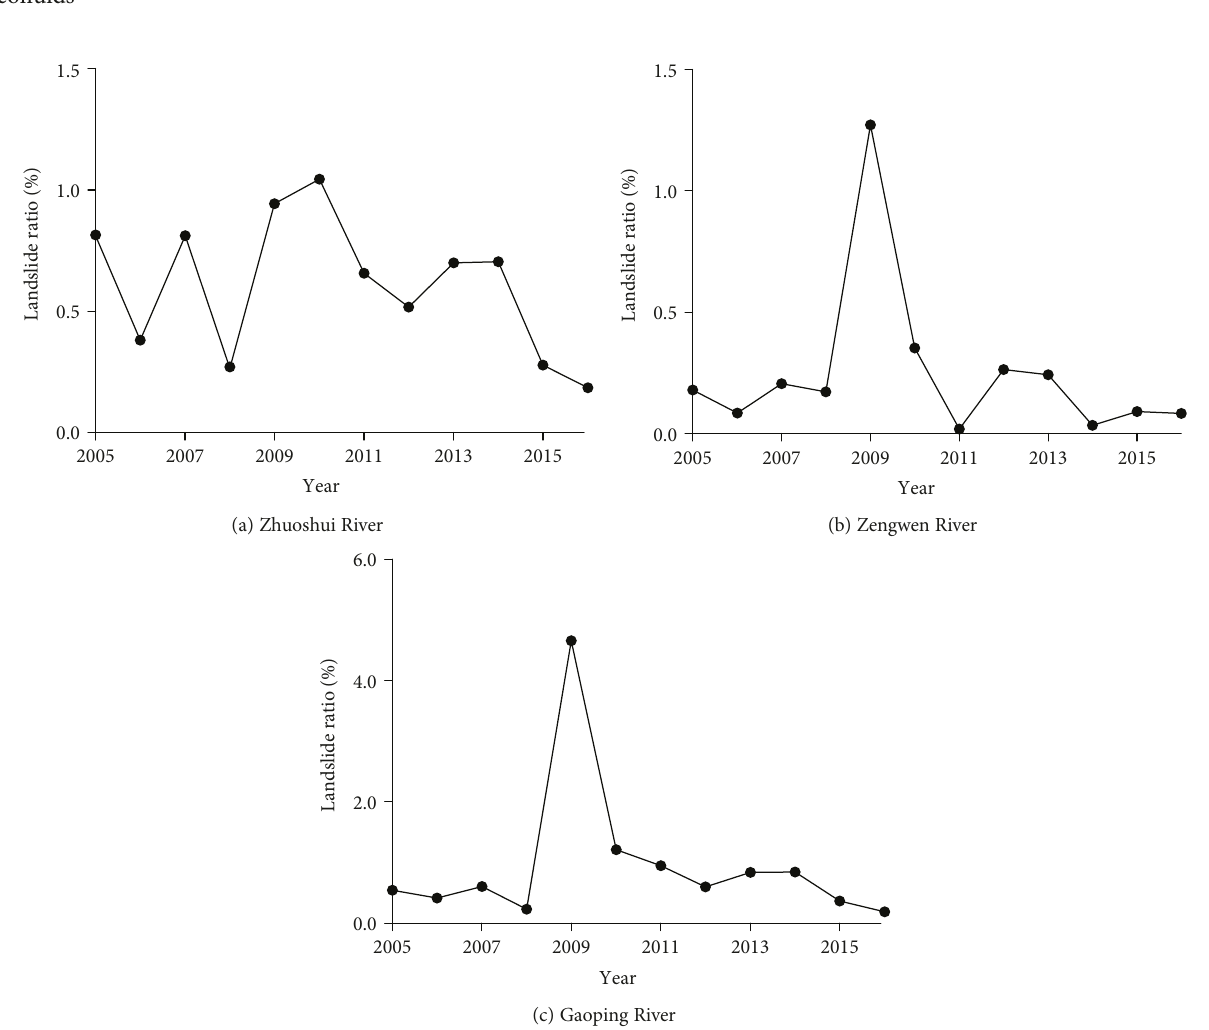
Figure 4: The variations of landslide ratios in the three catchments during 2005 –